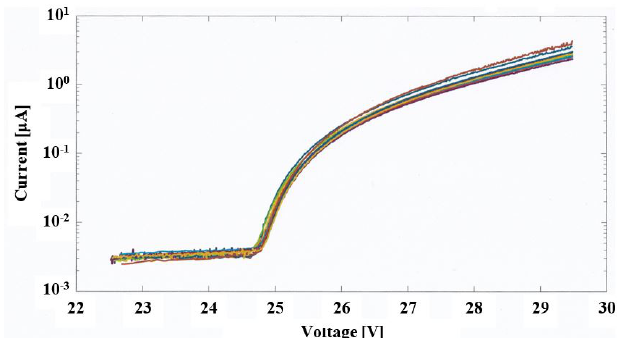
Fig. 1. I-V curve as a function of the bias voltage of ten C-series SiPM components. The ILD curve and the linear fit of the near breakdown voltages are shown in Fig. 2. The breakdown voltages that were obtained are presented in Fig. 3 over a normal probability density function plotted using the data for the C- 30050 series breakdown variation from Table I.